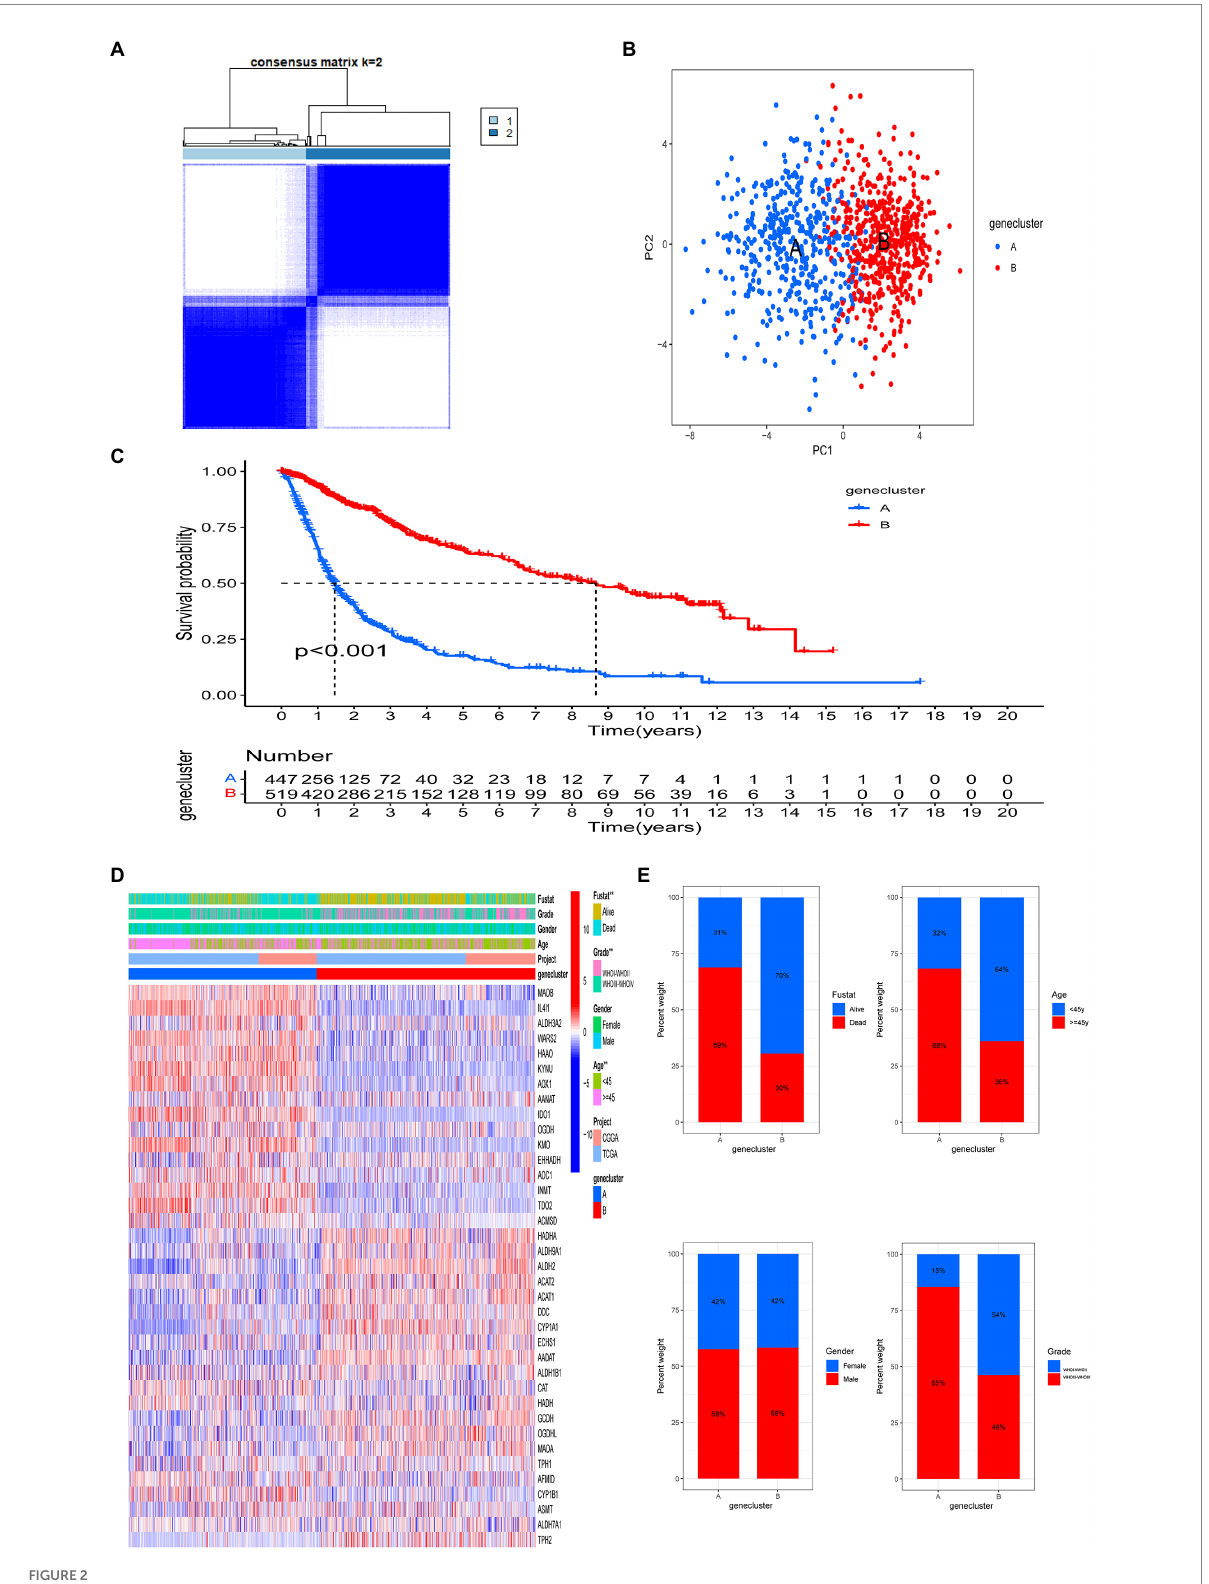
FIGURE 2 Two distinct tryptophan metabolic gene expression subtypes and the clinicopathological and biological characteristics of these subtypes, stratified by consistent clustering. (A) Consensus matrix heatmap defining two clusters ( k = 2) and areas of correlation. (B) Principal component analysis showing a notable difference in transcriptomes between the two subtypes. (C) Univariate analysis showing genetic subtypes related to overall survival (OS). (D) Differences in clinicopathologic features and tryptophan metabolic gene expression levels between the two subtypes. (E) Comparisons of OS status, gender, WHO tumor stage, and age between two genetic subtypes. Significance: ** p <